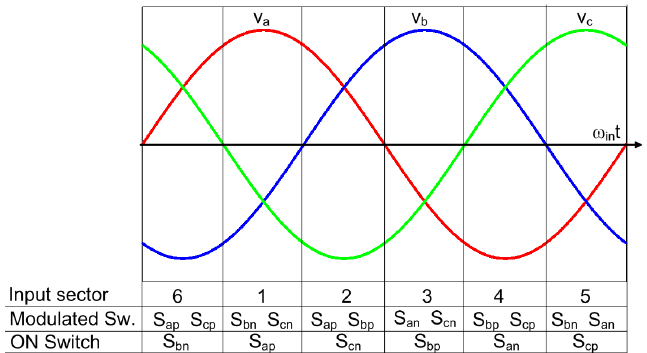
Figure 2. The definition of input sectors.